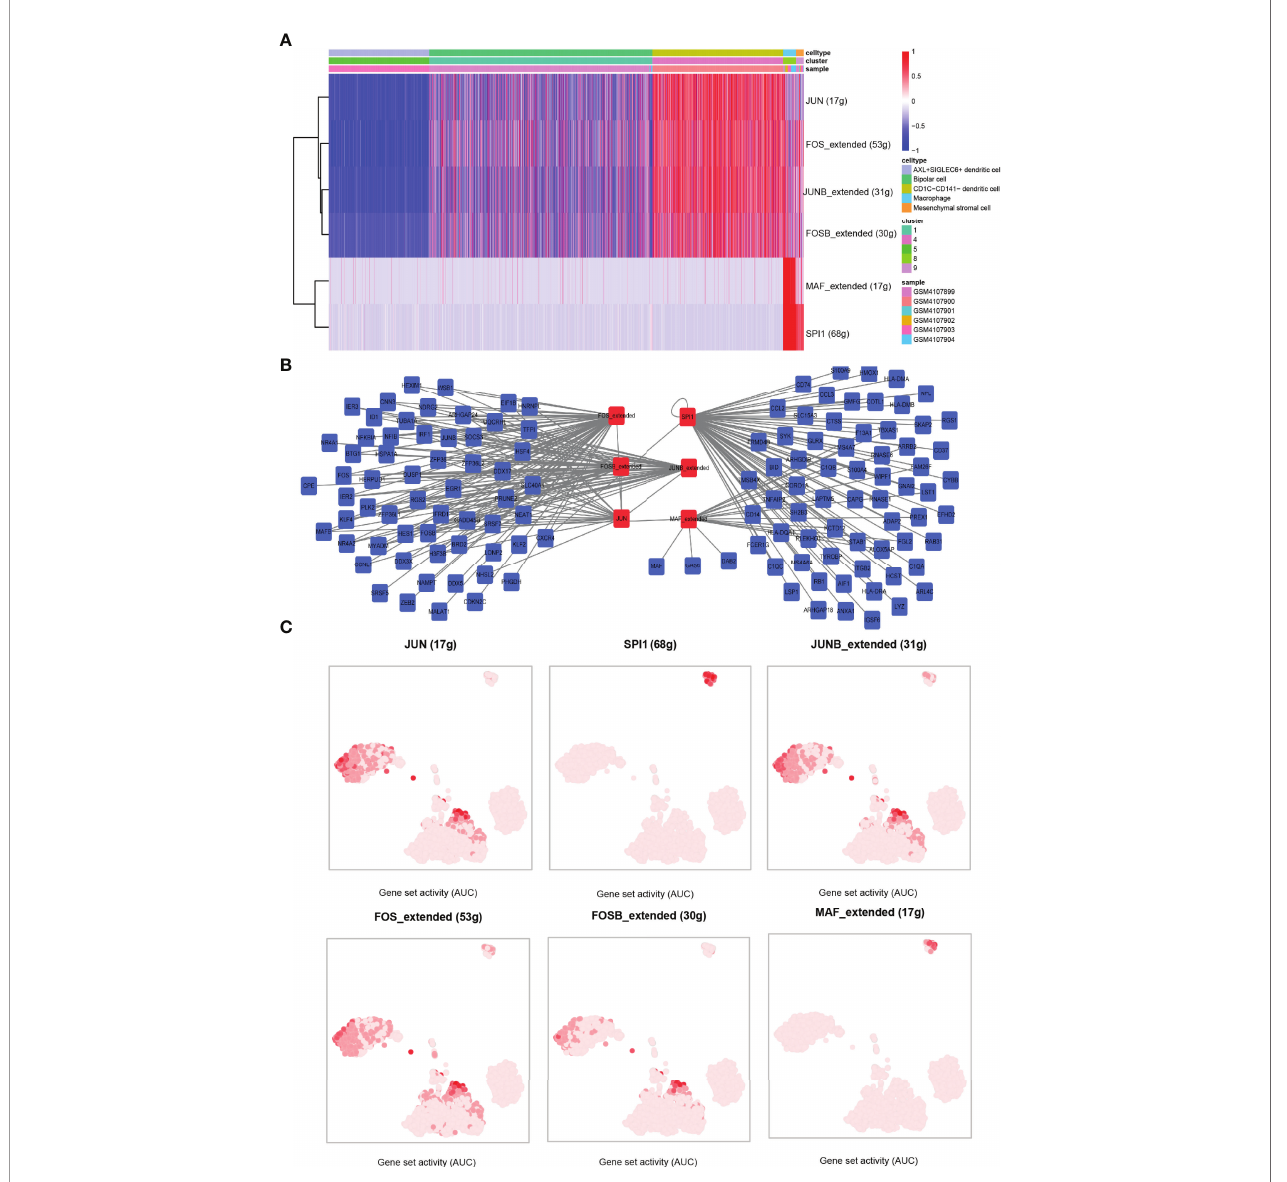
FIGURE 7 | Identi fi cation of transcription factor – target gene interactions using SCENIC. (A) The heat map showed the enrichment of TFs in the fi ve cell clusters, with blue representing AUC < 0 of z -score and red representing AUC > 0 of z -score. AUC values were normalized ( z -score) according to cells (horizontal axis). (B) TF – target gene interaction network. (C) In the tSNE dimension, the darker the AUC of transcription factors in each cell cluster, the higher the AUC value. AUC, area under the ROC